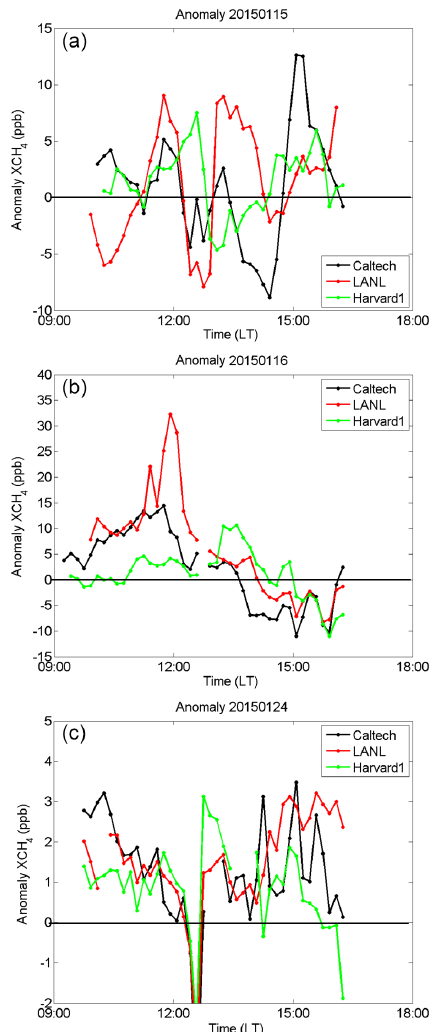
Figure 4. Time series of the 10min-average X CH ( (cid:49) X , in ppb) computed relative to the Harvard2 instrument for CH4 15 January (a) , 16 January (b) , and on 24 January 2015 (c) . Assuming the background levels X CH the instrument sites within 10 km distance and steady state wind fields, Eq. (3) can be written as